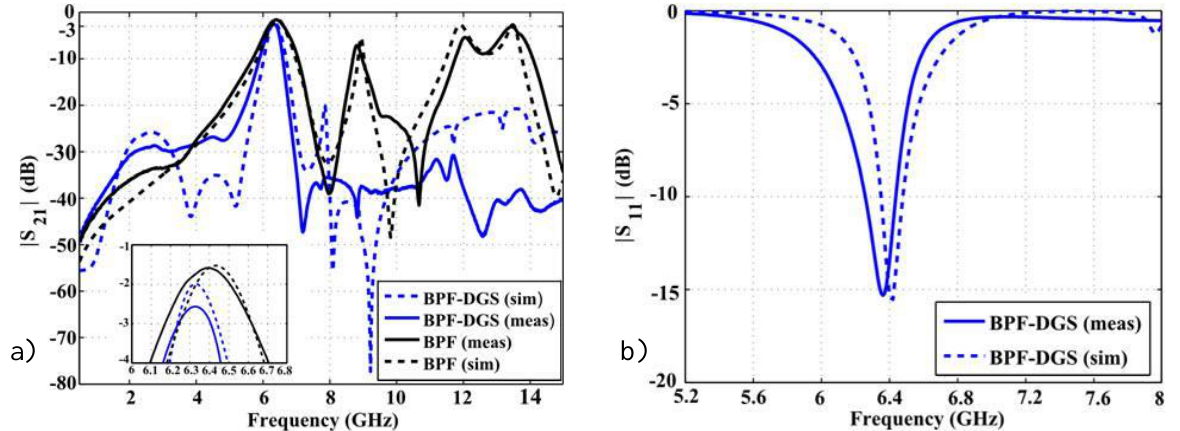
Figure 8. ( a ) S21 simulation and measurement results; and ( b ) S11 simulation and measurement